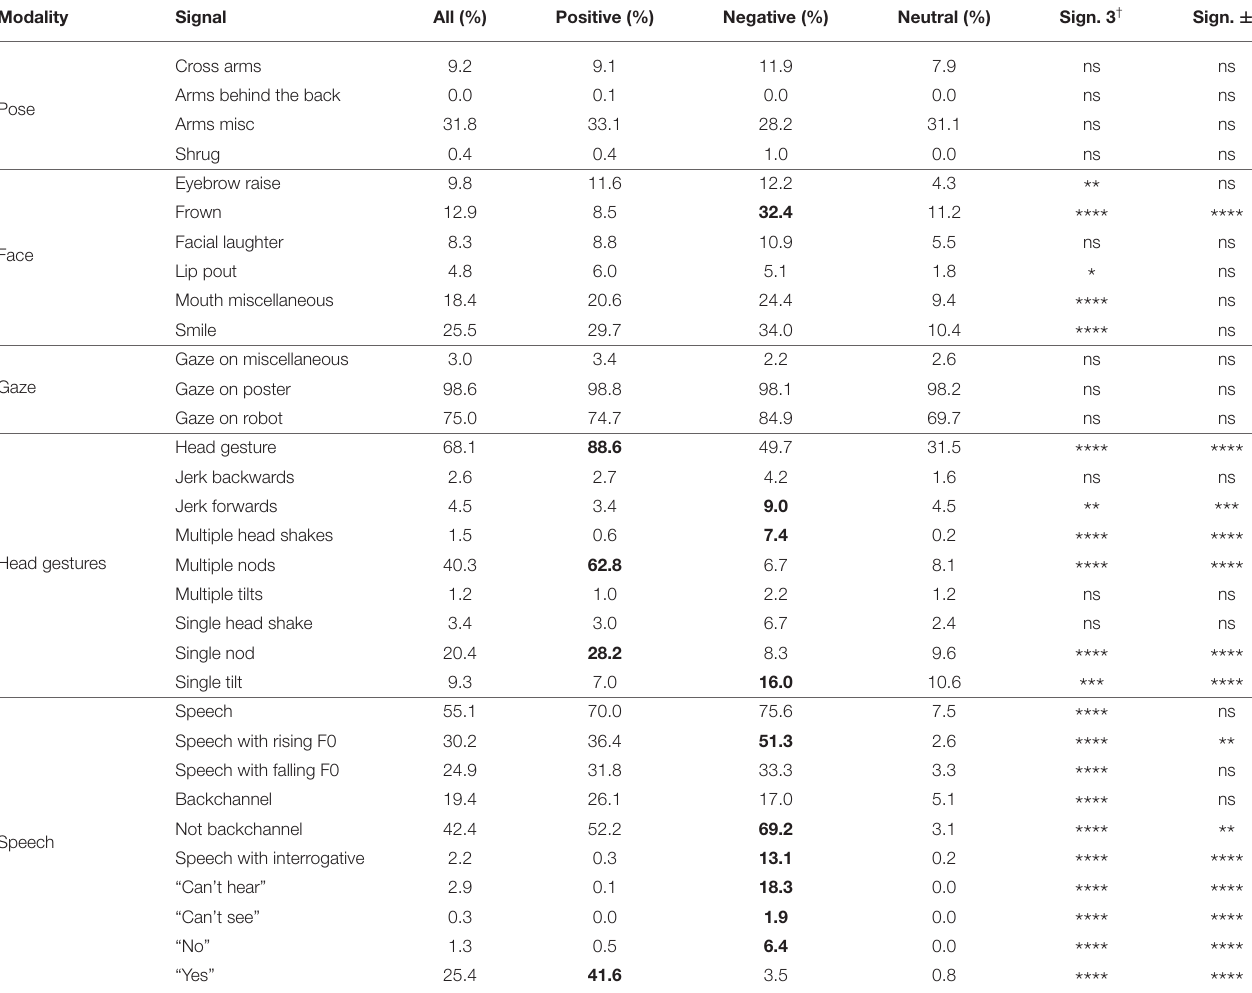
Signals are grouped by modalities. The right-most two columns present significance analyses of the distributions of the signals across clip labels, see section 4.1.1. If a signal is significantly different between positive and negative labels, the over-represented class is marked in bold. † χ 2 significance (Bonferroni-corrected) of the distribution on all three labels. ‡ χ 2 significance (Bonferroni-corrected) of the distribution of only positive and negative clips. ns, Not significant. * p < 0.05 / 32